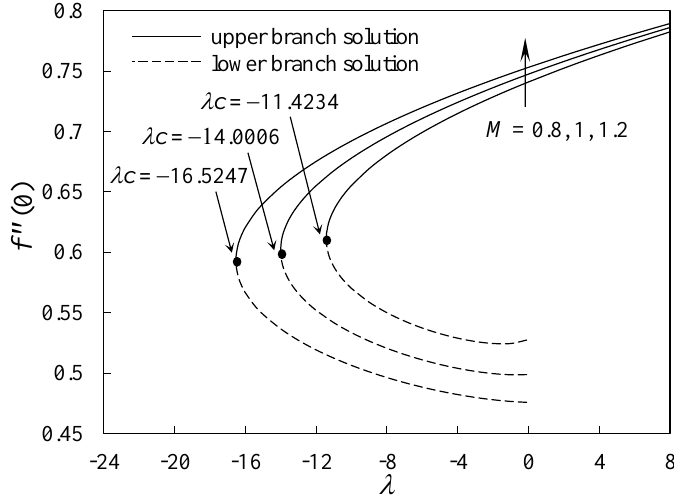
  0 f    0 f  with  for several values of M for Ag-water nanofluid. Figure 15. Variation of f (cid:48)(cid:48) ( 0 ) with λ for several values of M for Ag-water with  for several values of M for Ag-water nanofluid.